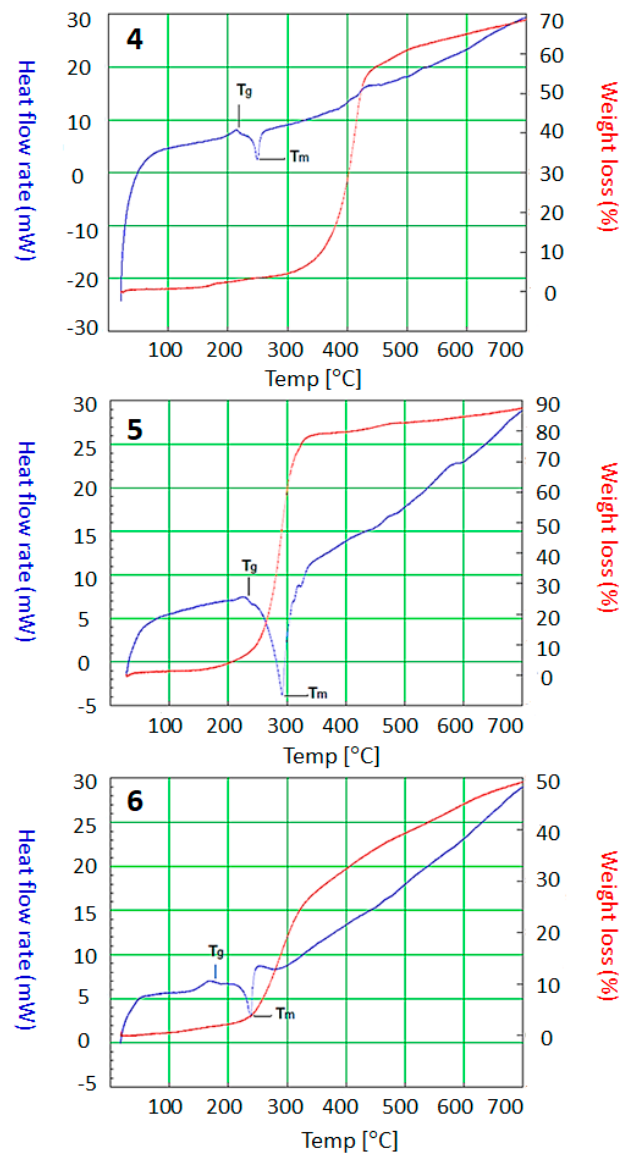
Figure 3. TGA and differential scanning calorimetry (DSC) spectra of polymers 4–6 . Table 4. T g , T m , and weight loss temperatures of polymers 4–6 .